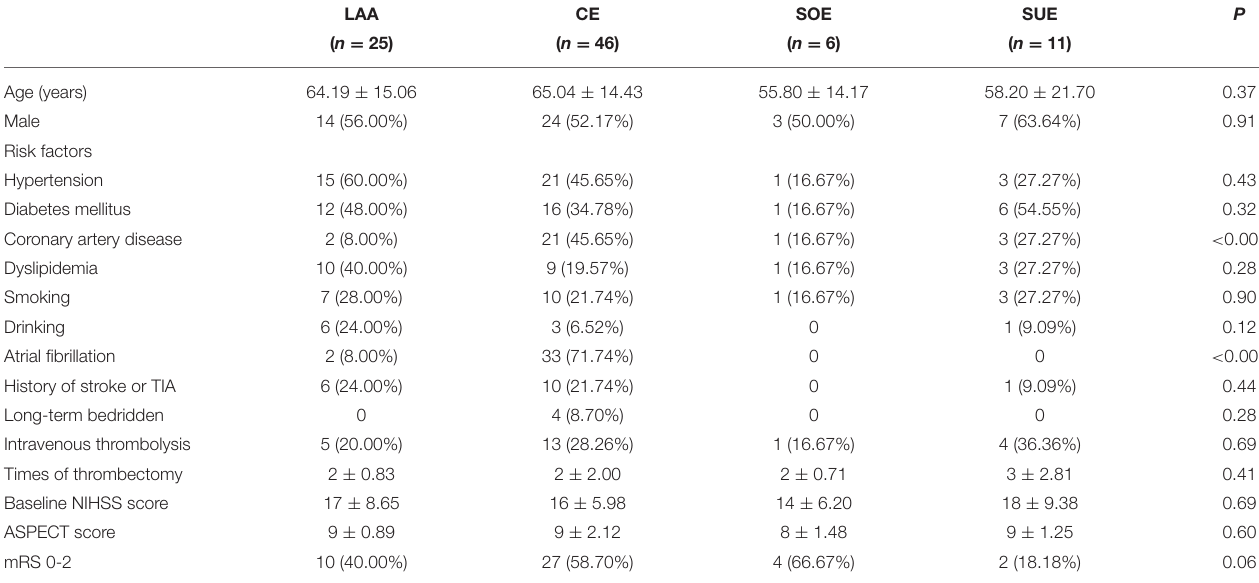
TABLE 2 | Clinical characteristics of stroke subtypes (TOAST).